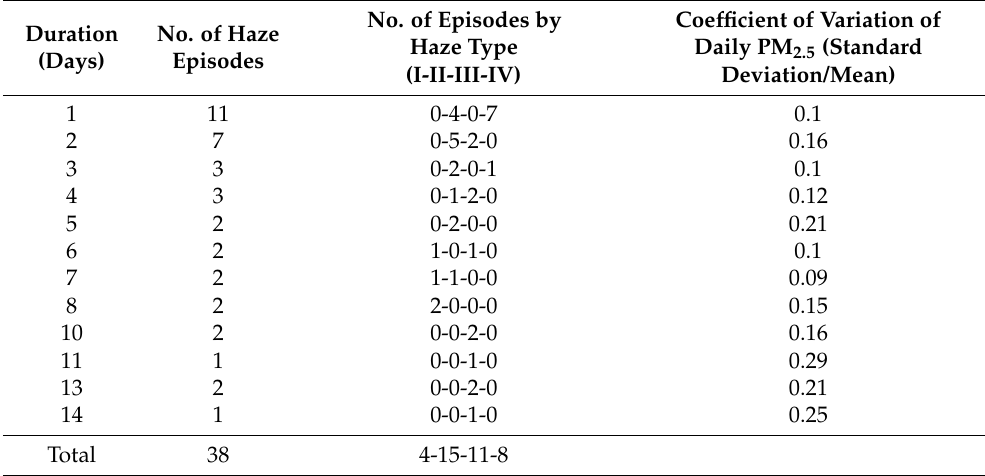
Figure 3. ( a ) Month-to-month variation. ( a ) Haze days; ( b ) haze episodes. In ( b ), the value above each bar is the average haze duration. Table 2. Number of haze episodes by haze durations.